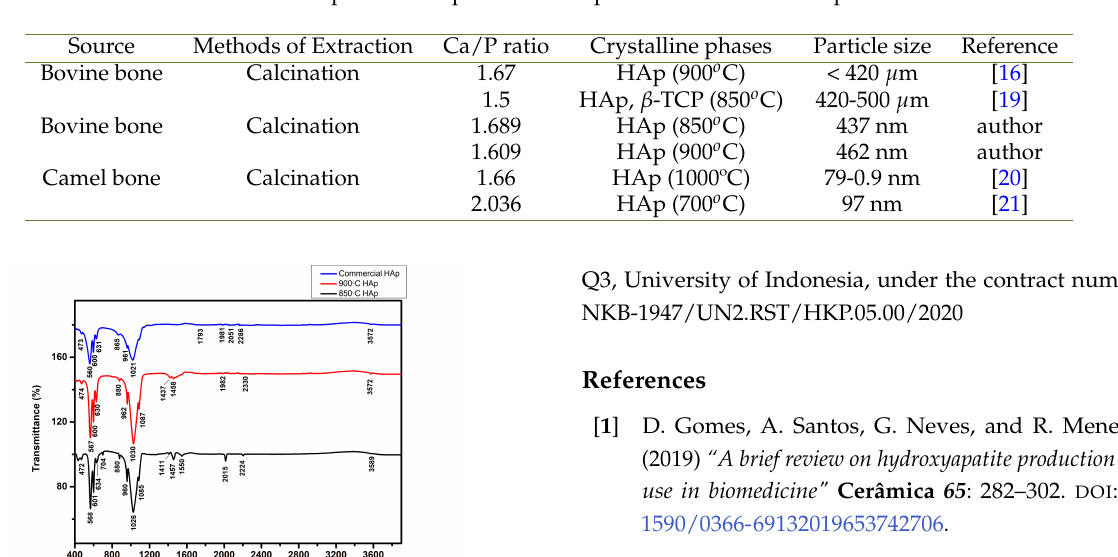
Table 4. Properties Comparison of HAp obtained with other reports.